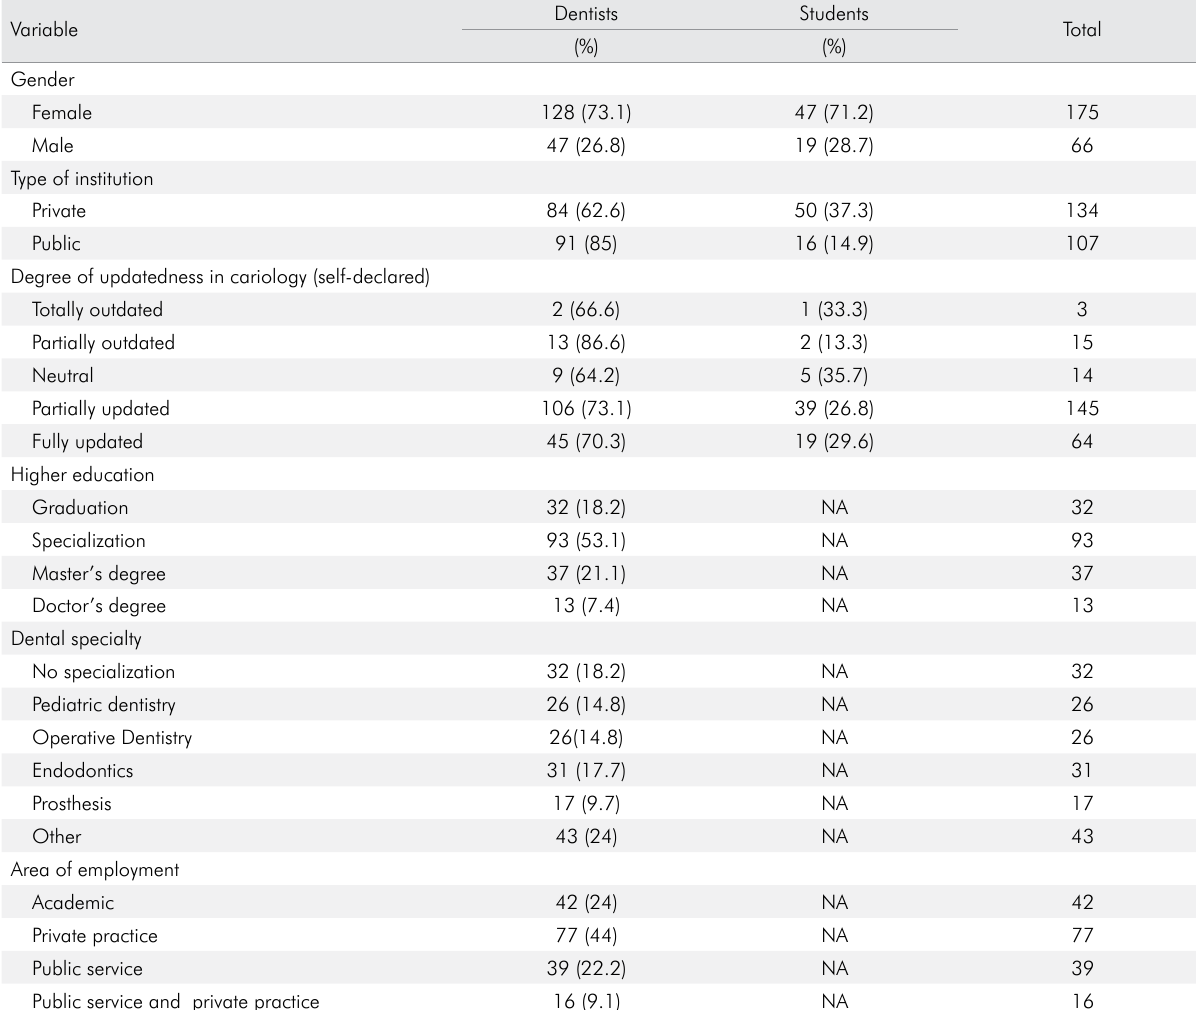
Table 1. Sampling characteristics of the